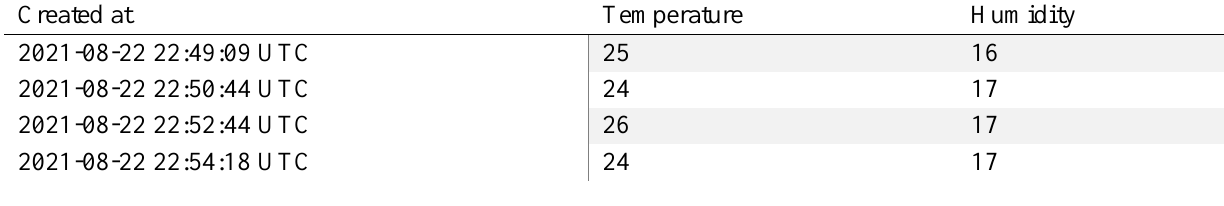
Table 2. DigiIncubator temperature and humidity